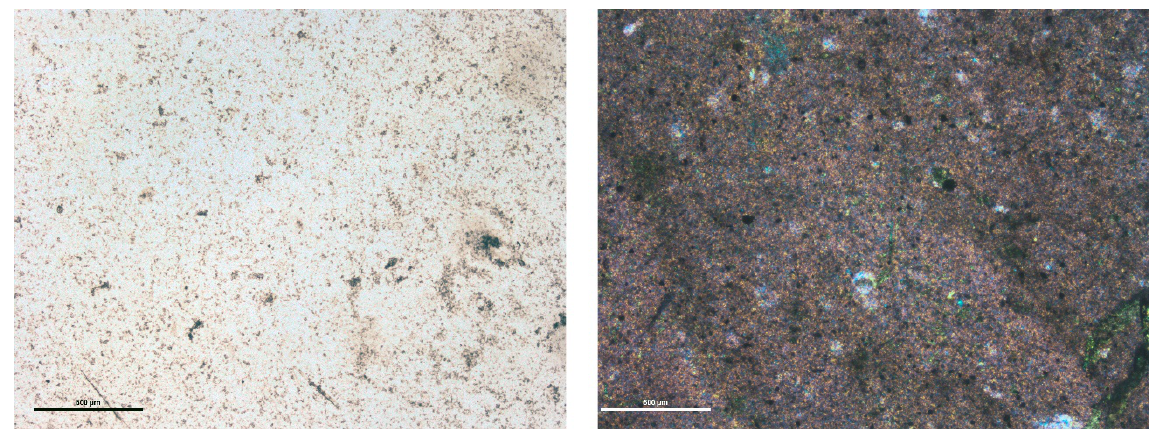
Figure 8. Radiolarites variety of the Pirulejo artefacts.